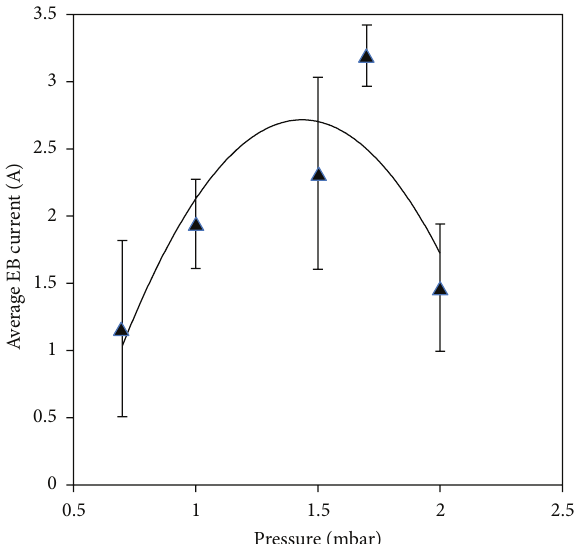
Figure 11: Variation of average electron beam current versus Argon gas pressure.